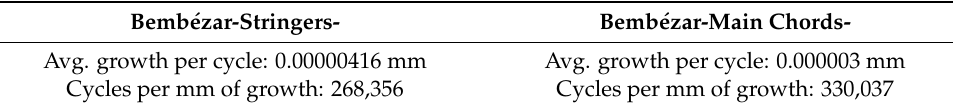
Table 7. Results (Bemb é zar): Avg. growth per cycle, cycles per mm of crack growth.